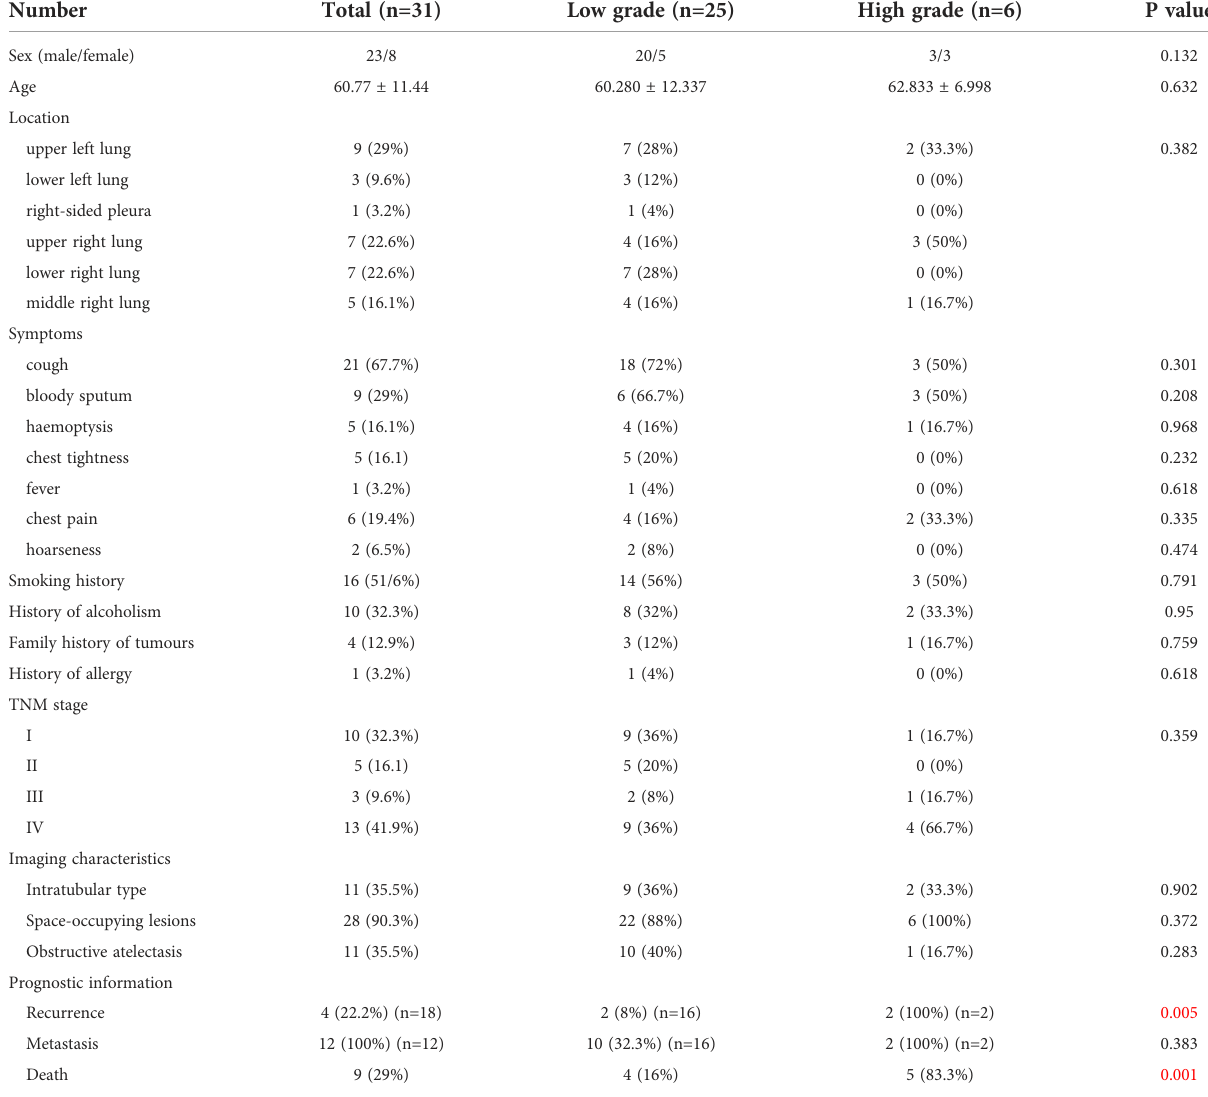
TABLE 1 Clinical and follow-up data of 31 patients with pulmonary mucoepidermoid